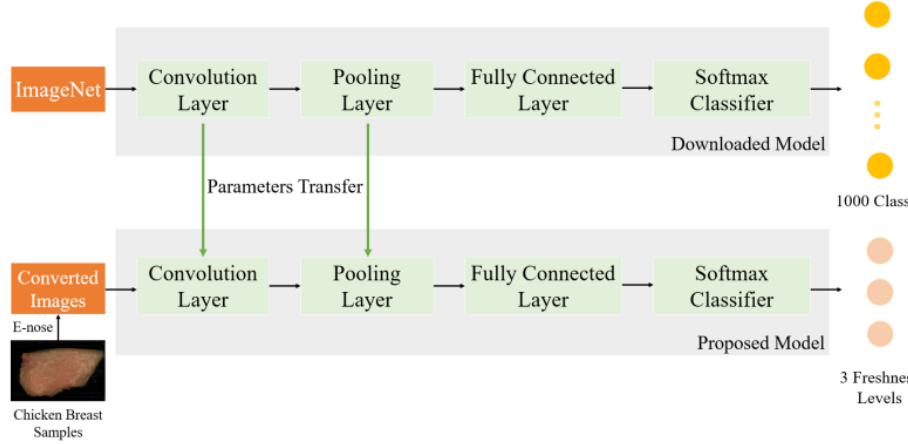
Figure 12. Transfer learning model.